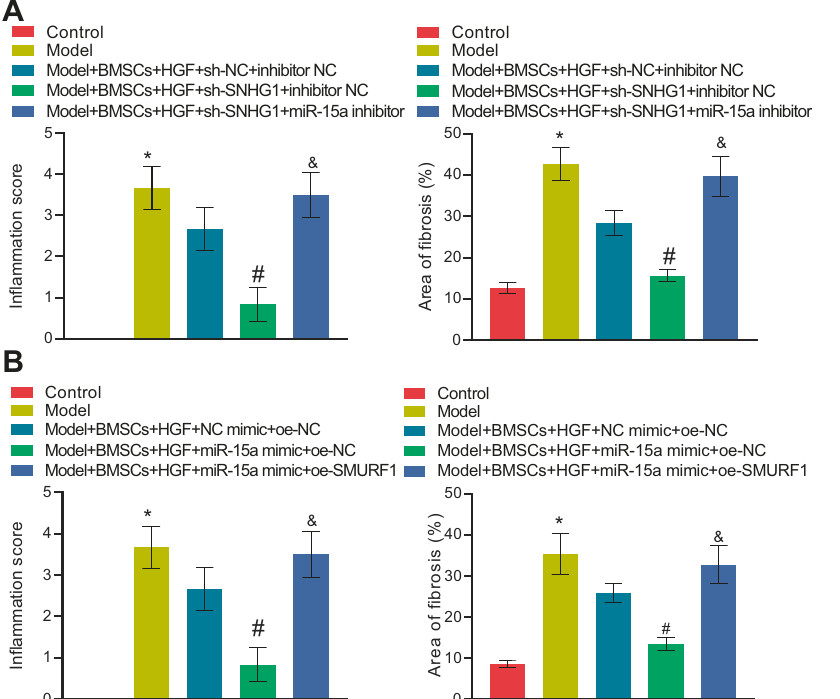
Fig. 7 LncRNA SNHG1 silencing attenuates cirrhosis in mice via the miR-15a/SMURF1 axis. A HE staining and Masson ’ s staining results of normal mice, cirrhotic mice, and mice treated with sh-lncRNA SNHG1 alone or in combination with miR-15a inhibitor. B HE staining and Masson ’ s staining results of normal mice, cirrhotic mice, and mice treated with miR-15a mimic alone or in combination with oe-SMURF1. N = 6 mice/group. * p < 0.05 vs . the Control group; # p < 0.05 vs . the Model + BMSCs + HGF + sh-NC + inhibitor NC or the Model + BMSCs + HGF + mimic NC + oe-NC group; and p < 0.05 vs . the Model + BMSCs + HGF + sh-SNHG1 + inhibitor NC or the Model + BMSCs + HGF + miR- 15a mimic + oe-NC